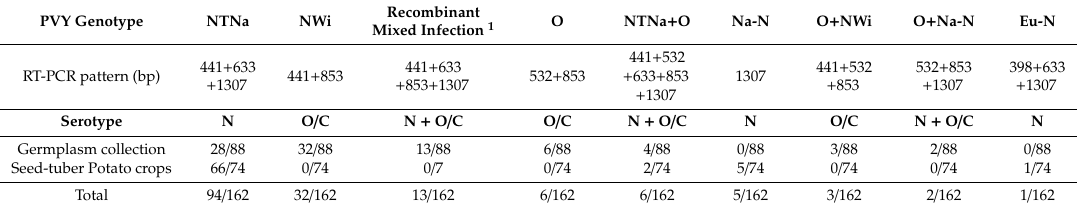
Table 2. Properties of PVY isolates infecting plant samples collected from the germplasm collection and from seed-tuber potato crops, as determined by DAS-ELISA with monoclonal antibodies and by multiplex RT-PCR for di ff erentiation PVY strain